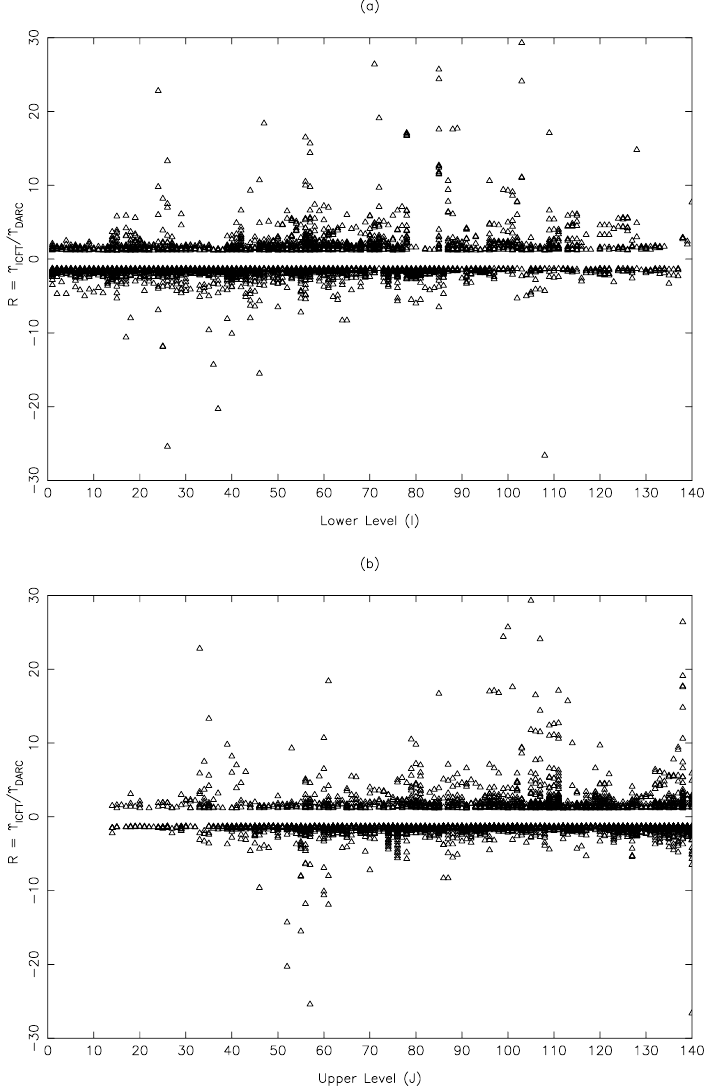
Figure 6. Comparison of DARC [55] and ICFT [70] values of Υ for transitions of Si III at T e = 1.8 × 10 6 K. Negative R values plot Υ DARC / Υ ICFT and indicate that Υ DARC > Υ ICFT . Only those transitions are shown that differ by over 20%. ( a ) Transitions from lower and ( b ) to upper